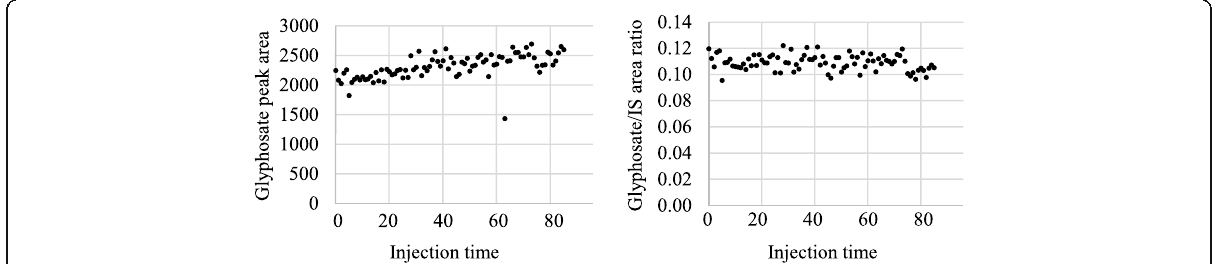
Fig. 4 Variations of repeat injection from one vial containing prepared sample (0.67 μ g/L of glyphosate). X -axis is the passage of time after the first analysis started, Y -axes are glyphosate peak area (left) or glyphosate/IS peak area ratio